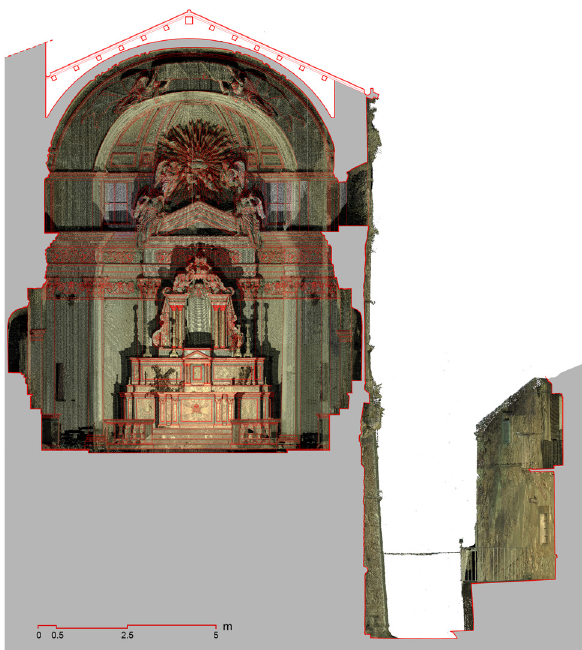
Fig. 5: Orthoprojection of the point cloud model. Transversal section of the